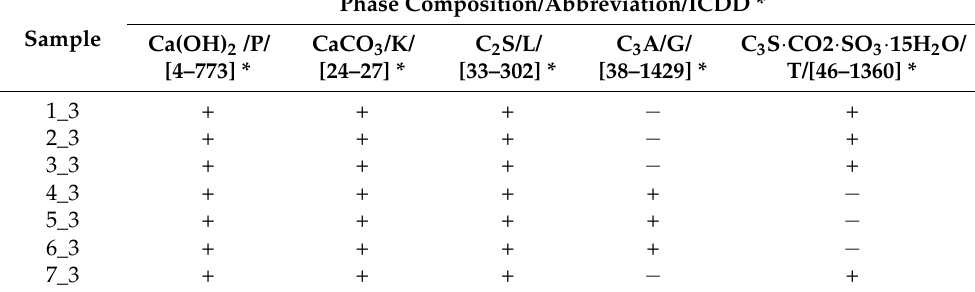
Figure 1. Diffractograms of the examined cement pastes; T-C 3 S · CO 2 · SO 3 · 15H 2 O, P-Ca(OH) 2 , K-CaCO 3 , L-C 2 S, G-C 3 A. Table 5. Phase composition of cement pastes [“+”—phase present in the sample; “ − ”—phase not detected in the sample].